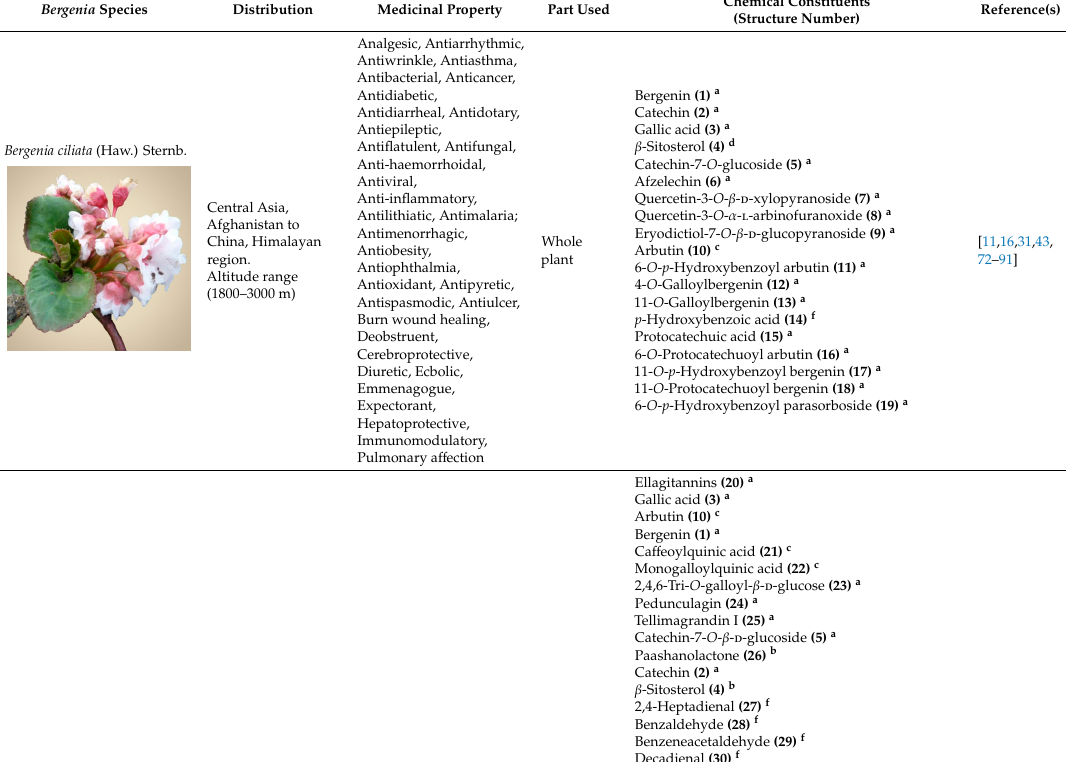
Table 1. Bioactive compounds and medicinal properties of different Bergenia species. Bergenia Species Distribution MedicinalProperty PartUsed ChemicalConstituents (StructureNumber) Reference(s)